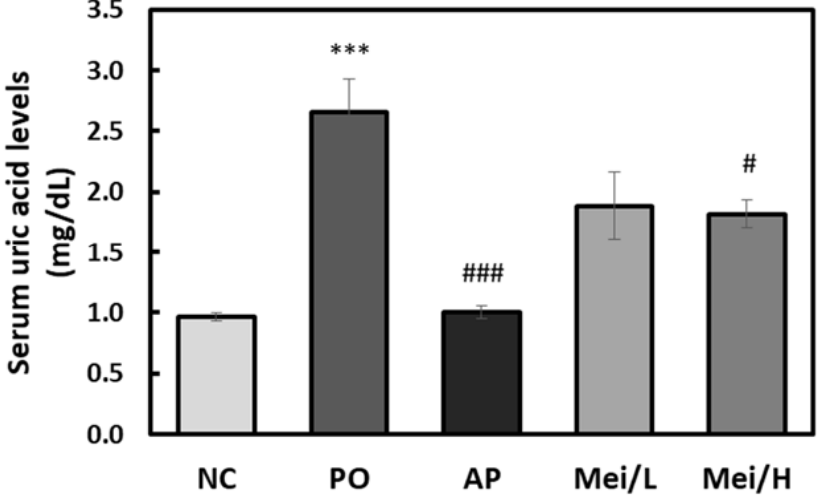
Figure 4. Effect of mei extract on serum uric acid levels of potassium oxonate (PO)-induced hype-ruricemic rats. AP represents treatment with allopurinol. Mei/L and Mei/H represents treatment with low and high dosage of mei extract, respectively. Data are presented as mean ± SEM ( n = 5–6). *** p < 0.001 compared with normal control (NC) and # p < 0.05, ### p < 0.001 compared with PO group.